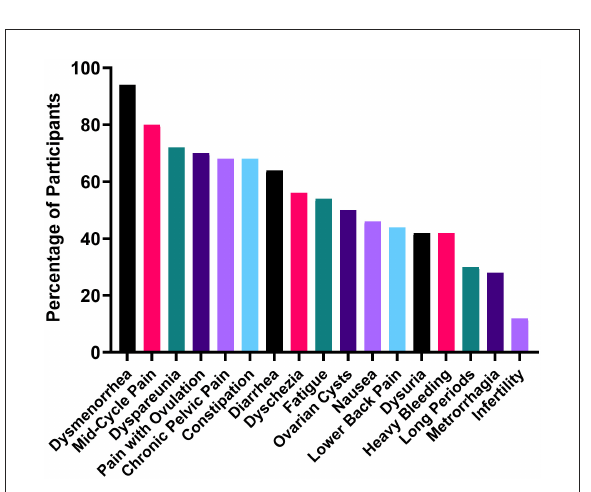
FIGURE1 Most commonly reported endometriosis symptoms.